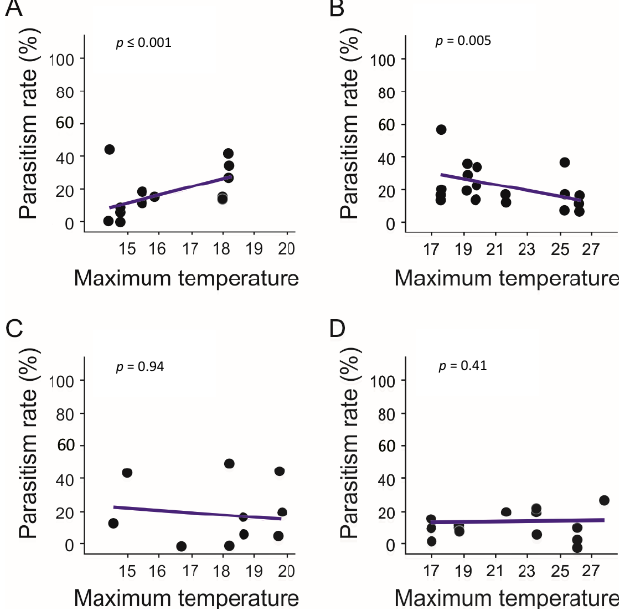
Figure 5. Effect of maximum temperature on parasitism rate in ( A ) Zone 1 and ( B ) Zone 2 throughout 2017; and ( C ) Zone 1 and ( D ) Zone 2 throughout 2018. p indicates the p -value obtained from GLMM.